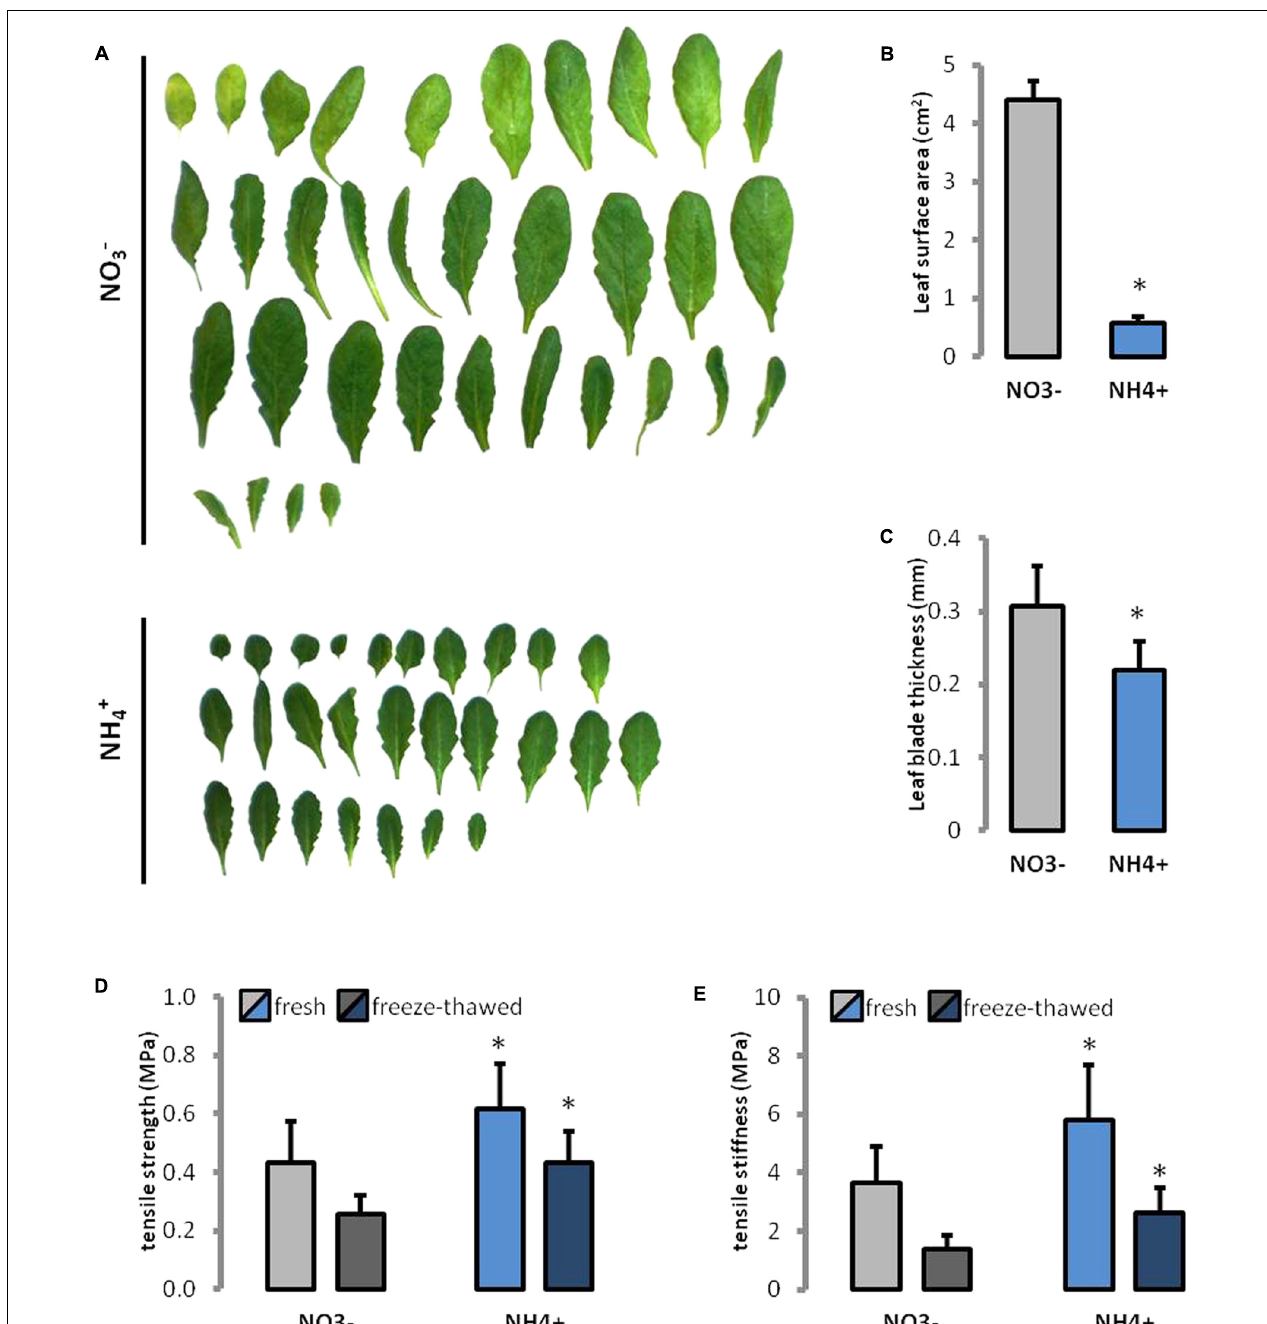
FIGURE 1 | Leaf phenotype recorded in Arabidopsis thaliana growing on NH 4 + and NO 3 − (control) as the only N source. (A) Leaves were ordered from the oldest to the youngest. (B) Leaf area, and (C) thickness of the leaf lamina of the ninth fully expanded leaf. Mechanical properties of leaves, (D) the tensile strength, and (E) tensile stiffness were measured in fully hydrated fresh leaves and in rehydrated frozen-thawed (1 h at –20 ◦ C) tissues.